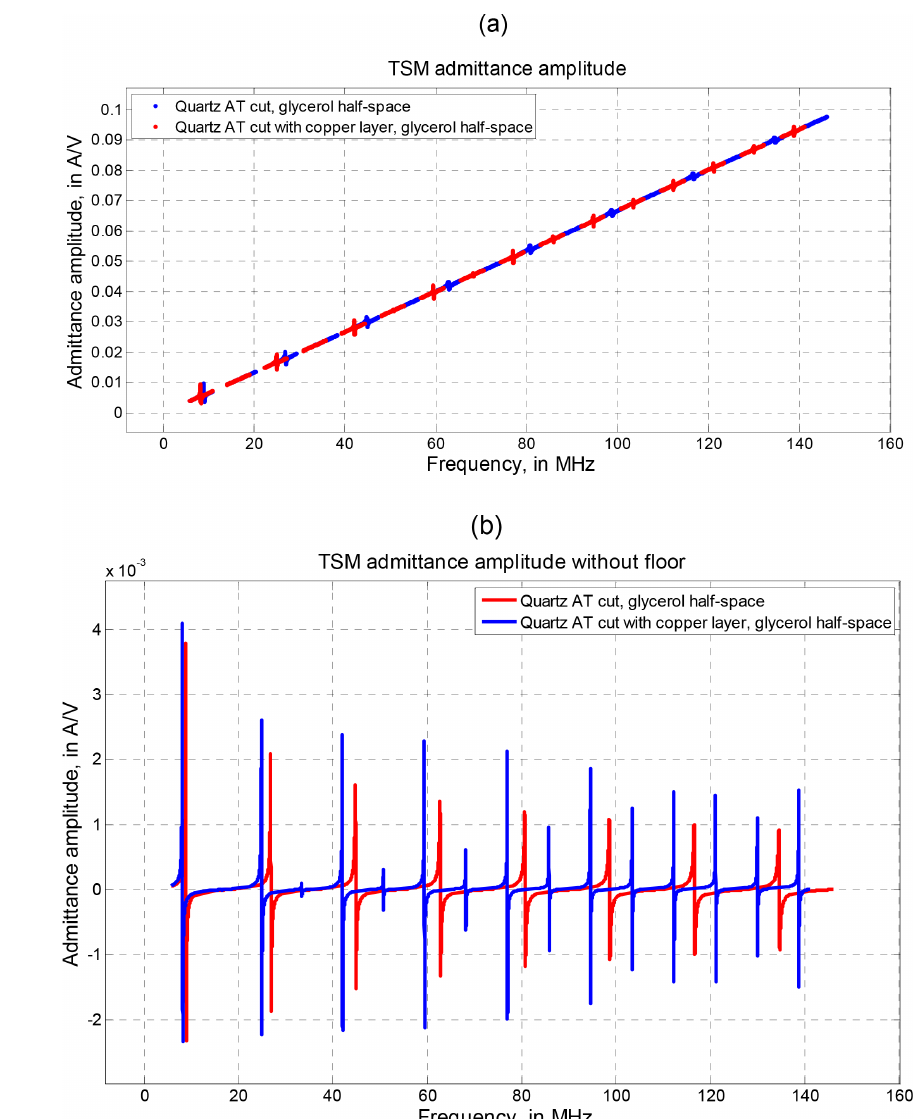
Figure 3. Calculated admittance amplitude as a function of frequency according to Eq. (32) for two cases of TSM material configurations: (1) AT-cut quartz plate with a liquid half-space of glycerol and (2) the same system as in (1), but with an additional copper layer below glycerol. The frequency range is extended over 16 resonances and anti-resonances; (a) with and (b) without floor